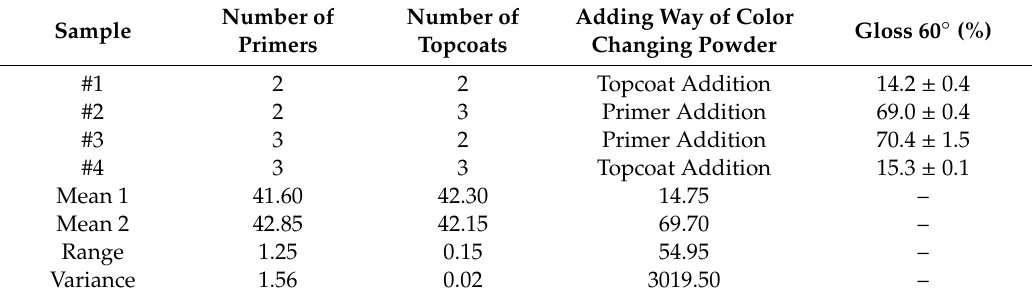
Table 5. Orthogonal experiment table of the influence of coating technology on the gloss of the color-changing paint